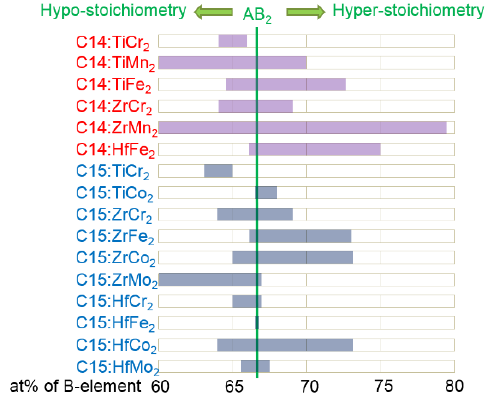
Figure 8. Comparison of solubilities (flexibility in stoichiometry) for the C14 and C15 binary alloys with Ti, Zr, or Hf as the A ‐ site element (date from [115]).